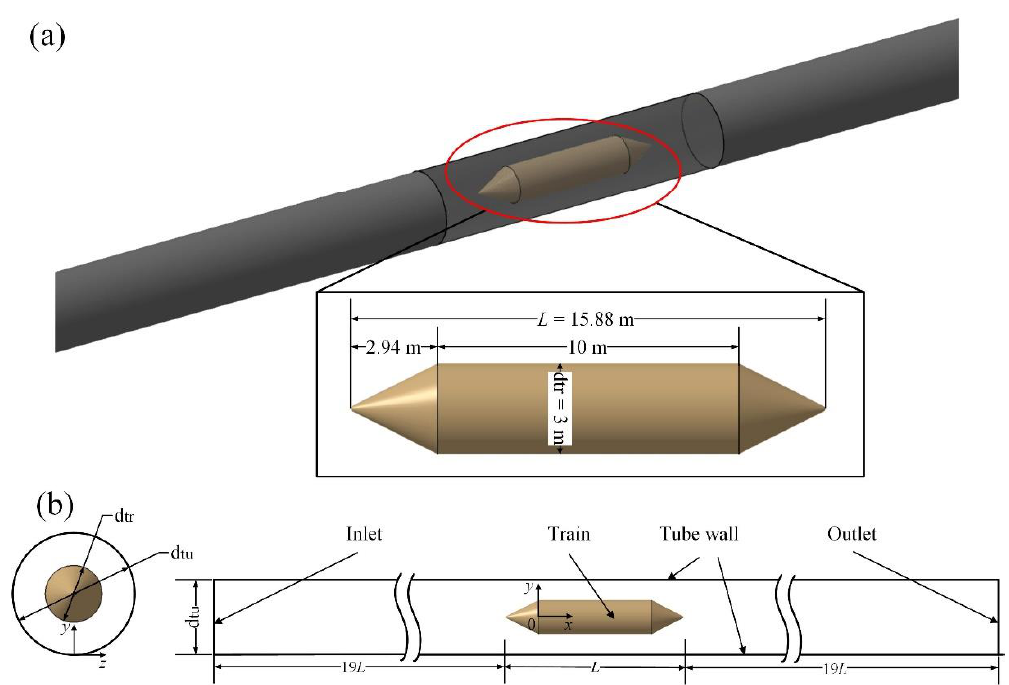
Figure 1. ( a ) Three-dimensional diagram of the ETT system, ( b ) Two-dimensional diagram of the computational domain.